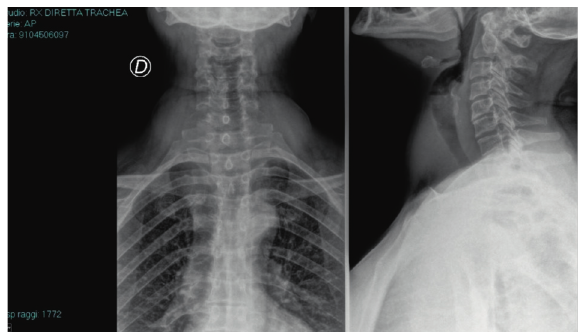
Figure 1: Direct trachea X-ray (Case